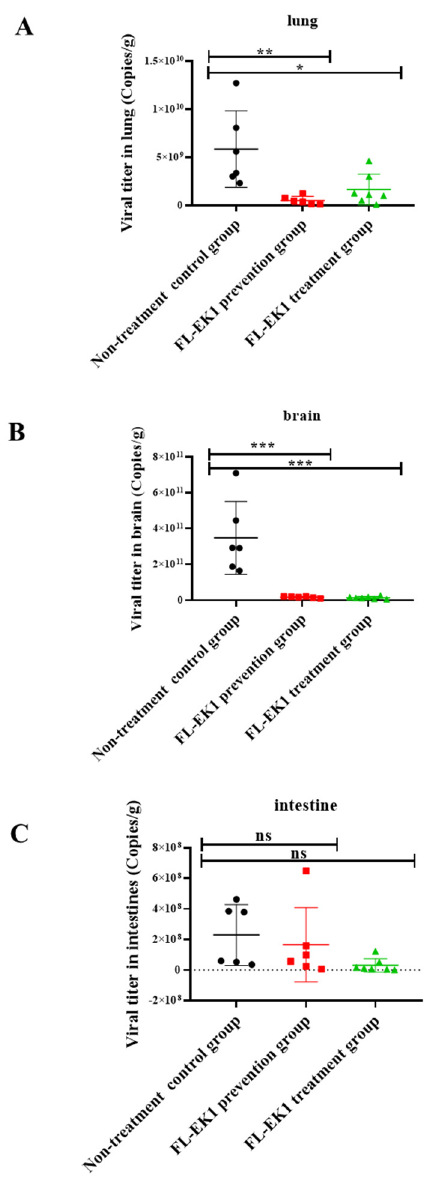
Figure 5. FL-EK1-mediated inhibition of authentic SARS-CoV-2 Delta variant infection in vivo. Prophylactic and protective efficacy of FL-EK1 against SARS-CoV-2 Delta variant infection in Tgtn mice via the intranasal route for FL-EK1 administration and viral challenge. Viral titer in lung ( A ), brain ( B ), and intestine ( C ) was measured by real-time PCR. Samples were tested in triplicate, and the RT-PCR was repeated twice. Data from a representative experiment are presented as mean ± SD. ns, no significance, * p < 0.05, ** p < 0.01, *** p <